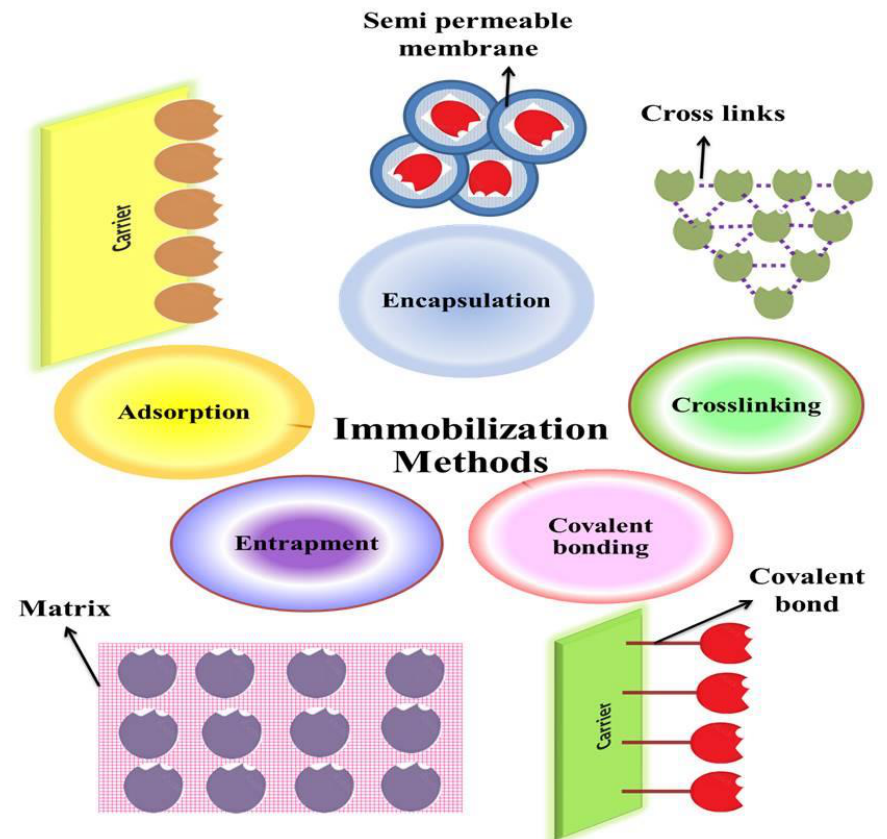
Figure 3. Schematic representation of different enzyme immobilization methods.